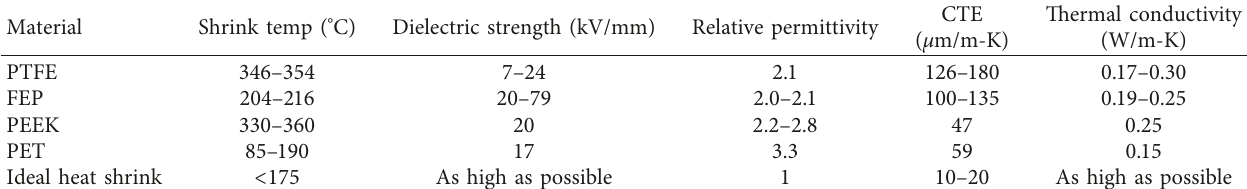
Table 1: Important properties for selected heat shrink